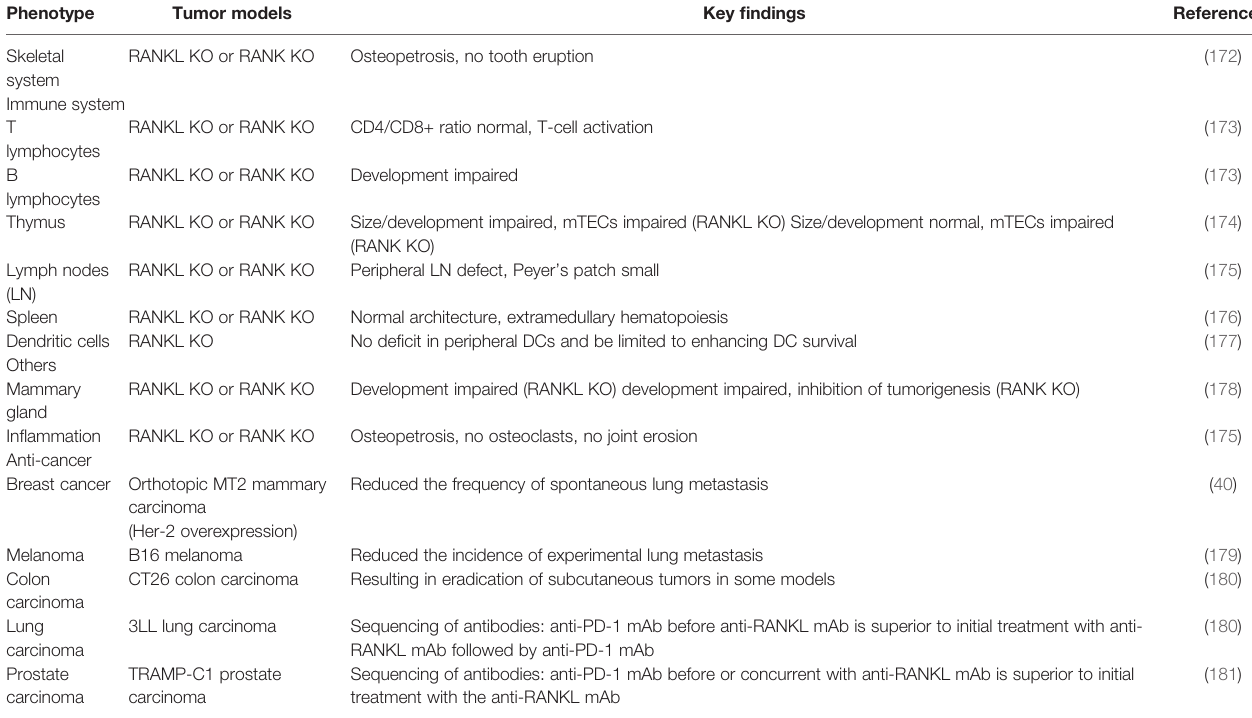
TABLE 2 | Mice genetic phenotypes on the RANKL/RANK